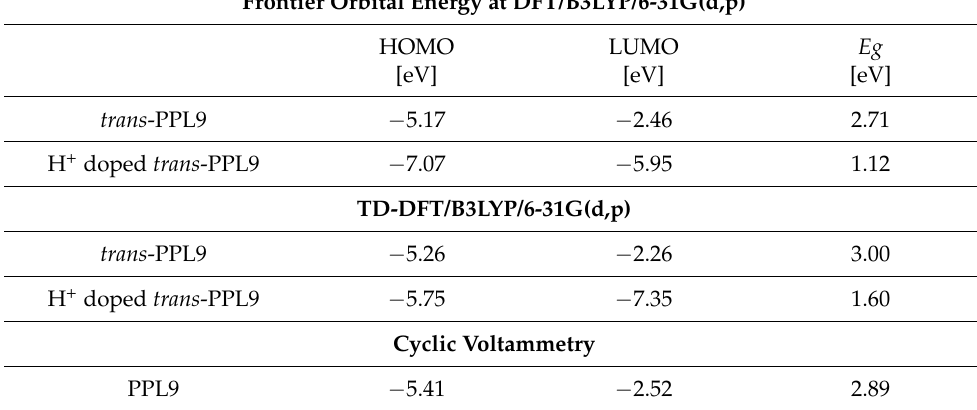
Table 4. Comparison of theoretical and experimental values of E g and energies of HOMO LUMO levels for trans -PPL9 in undoped and doped state (1:1 w / w